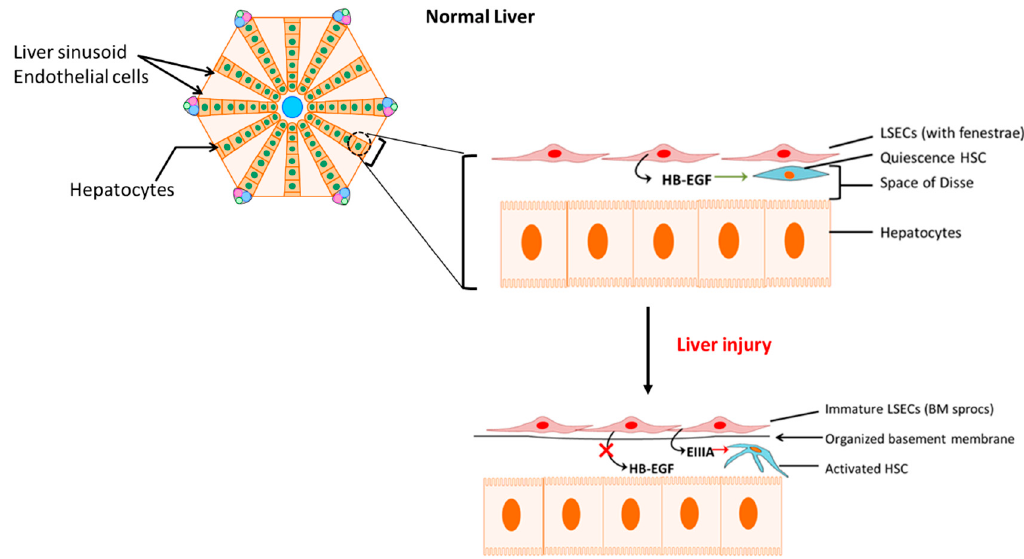
Figure 2. Activation of hepatic stellate cells (HSCs) by immature liver sinusoidal endothelial cells (LSECs). Reduced release of heparin-binding epidermal growth factor (HB-EGF) with concomitant increase in fibronectin isoform EIIIA release by bone marrow-derived immature LSECs activates HSCs. BM sprocs, bone marrow (BM) derived sinusoidal endothelial cell progenitor cells (sprocs). BM: bone marrow; HB-EGF: heparin-binding epidermal growth factor.